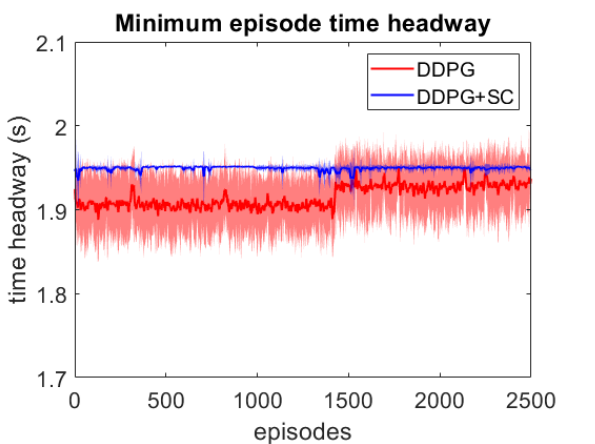
Figure 6. Comparison of the deep vehicle following agents’ minimum TH per episode over adversar- ial training runs with lead vehicle velocity limits v lead ∈ [ 17,40 ] m/s. Averaged over 3 runs, with standard deviation shown in shaded colour.